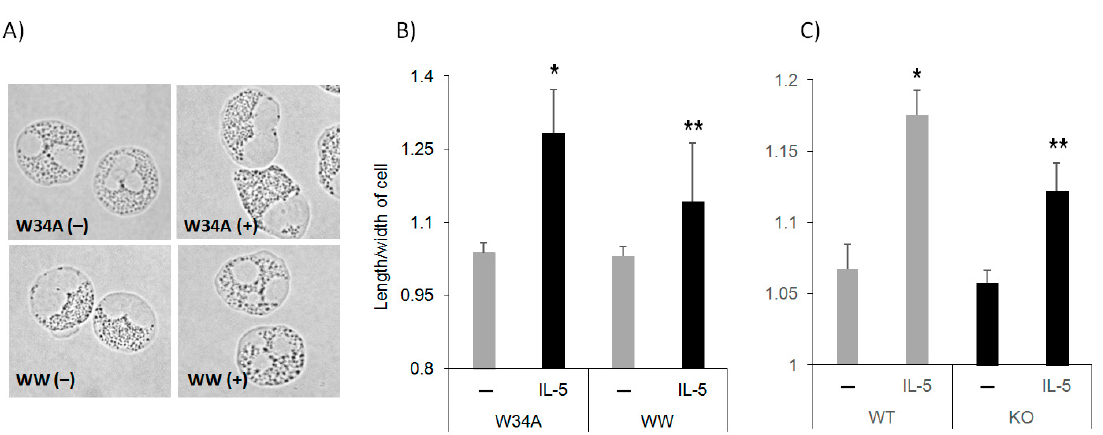
Figure 1. Pin1 is required for IL-5-induced Eos polarization. ( A ) Human peripheral blood Eos (>98% pure, >95% viable) were starved for 3 h prior to incubation with Pin1 inhibitor (TAT-WW, 100 nM) or control peptides (TAT-W34A) for 1 h before treatment with hIL-5 (50 ng/mL) for 10 min. ( B ) The length and width of cells from ( A ) were measured by ImageJ. ( C ) BM-derived mouse Eos were starved (3 h) before treatment with mIL-5 (50 ng/mL) for 10 min. Data from three independent experiments. * p < 0.05 between untreated (–) and IL-5 in W34A-treated cells, ** p < 0.05 between IL-5 treatments.